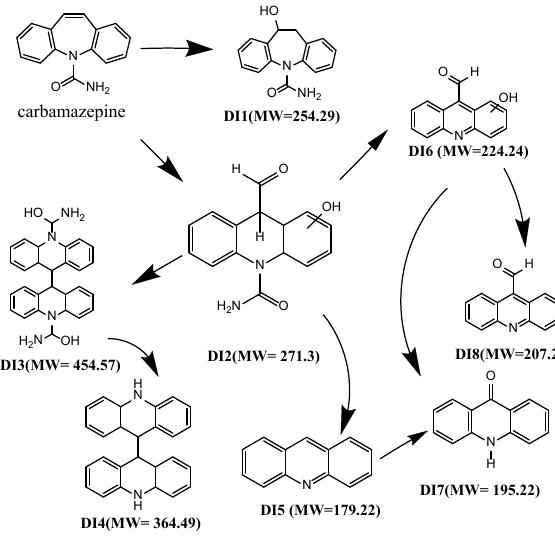
Figure 7 : The proposed structures and pathways of the main photo- transformation detected intermediates (DI) (based on LC/MS scan of CBZ intermediates and Chiron et al.